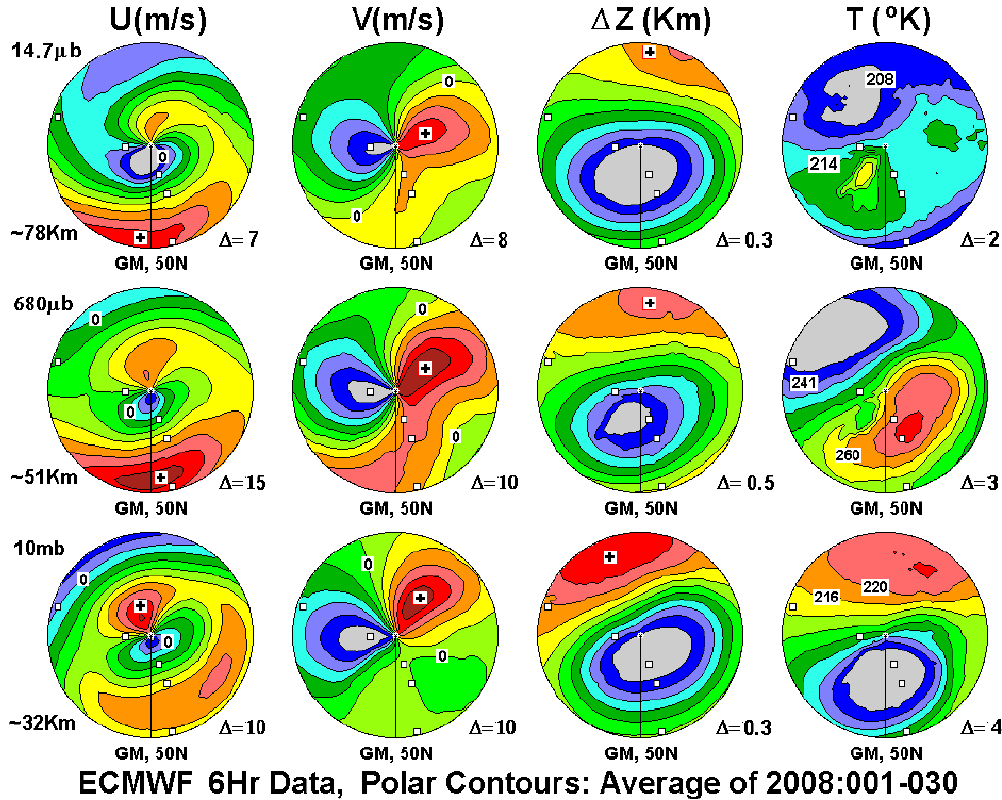
Fig. 2. Polar projection plots, linear in latitude, at three constant pressure surfaces (circa 32, 57 and 78km) from the ECMWF model data (European Centre Medium Range Weather Forecasting), January 2008, is shown from 50 ◦ N to North Pole, with contours of winds (EW, U , zonal; NS, V , meridional), and colored spacing ( 1) of contours in ms − 1 at each surface; geopotential-height Z contours, with 1Z provided in km at each surface; and temperature ( T ), with 1T provided in degrees Kelvin for each surface. In most cases, qualitative understanding is achieved by noting that red is the largest and/or positive contour, and blue-silver the smallest/negative contour. To reduce clutter, just one or two labels are shown per plot, which along with the contour step (shown at bottom right of a plot) are enough to identify each contour. The locations of Svalbard, Tromsø and Collm in the Eastern Hemisphere; and Eureka and Saskatoon in the west, are shown with open squares. For numbers associated with the variables, these steps are needed: for the plots of winds, the zero contour is marked (0), as well as the sign (+) of the first positive colored contour difference, so that absolute speeds with sign can be calculated as needed; for the plots of geopotential ( Z ) the contour difference 1Z of greatest height is marked with the + symbol, so that the “depth” of a vortex can be calculated relative to the provided height for the surface; and the temperature of two contours is provided so that the temperature of any contour can be calculated if